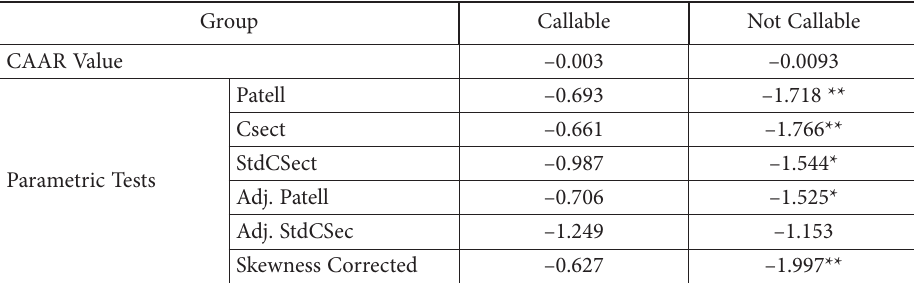
Table 6. Results of grouping the announcements by the callable feature (source: own design)